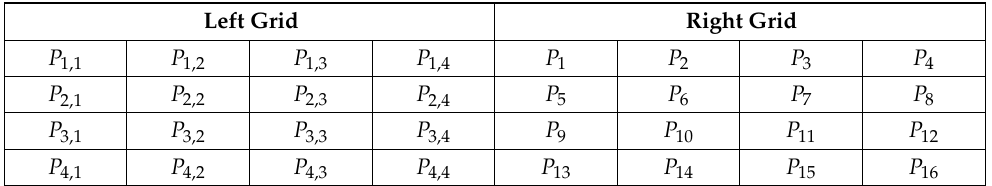
Table A2. For a 224 × 224 image, grid of its 16 patches of size 56 × 56, represented as P i , j (left grid), and as P 1 , ⋯ , P 16 (right grid) as used by the permutations σ k .